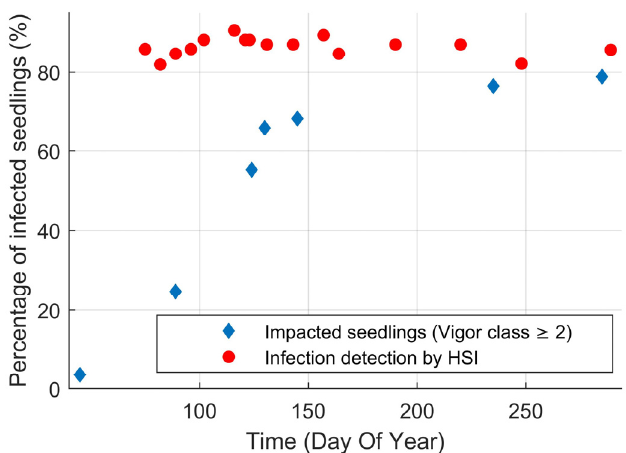
Figure 3. Percentage of infected seedlings over time whose vigor was impacted by the rust (vigor class ≥ 2) and percentage of infected seedlings that were identified as being infected by hyperspectral imaging (averaged). Note that at the start of the experiment, HSI was able to successfully identify 80% of the inoculated seedlings when only 20% were vigor-impacted.